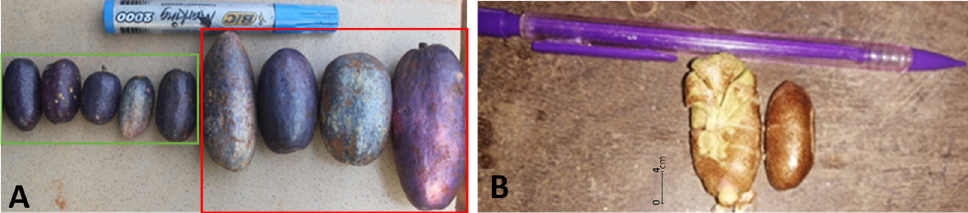
Figure 2. Morphological differences between wild and cultivated fruits and seeds of D. edulis . ( A ) Wild (squared in green) and cultivated fruits (squared in red); ( B ) a cultivated (left) and a wild seed (right).